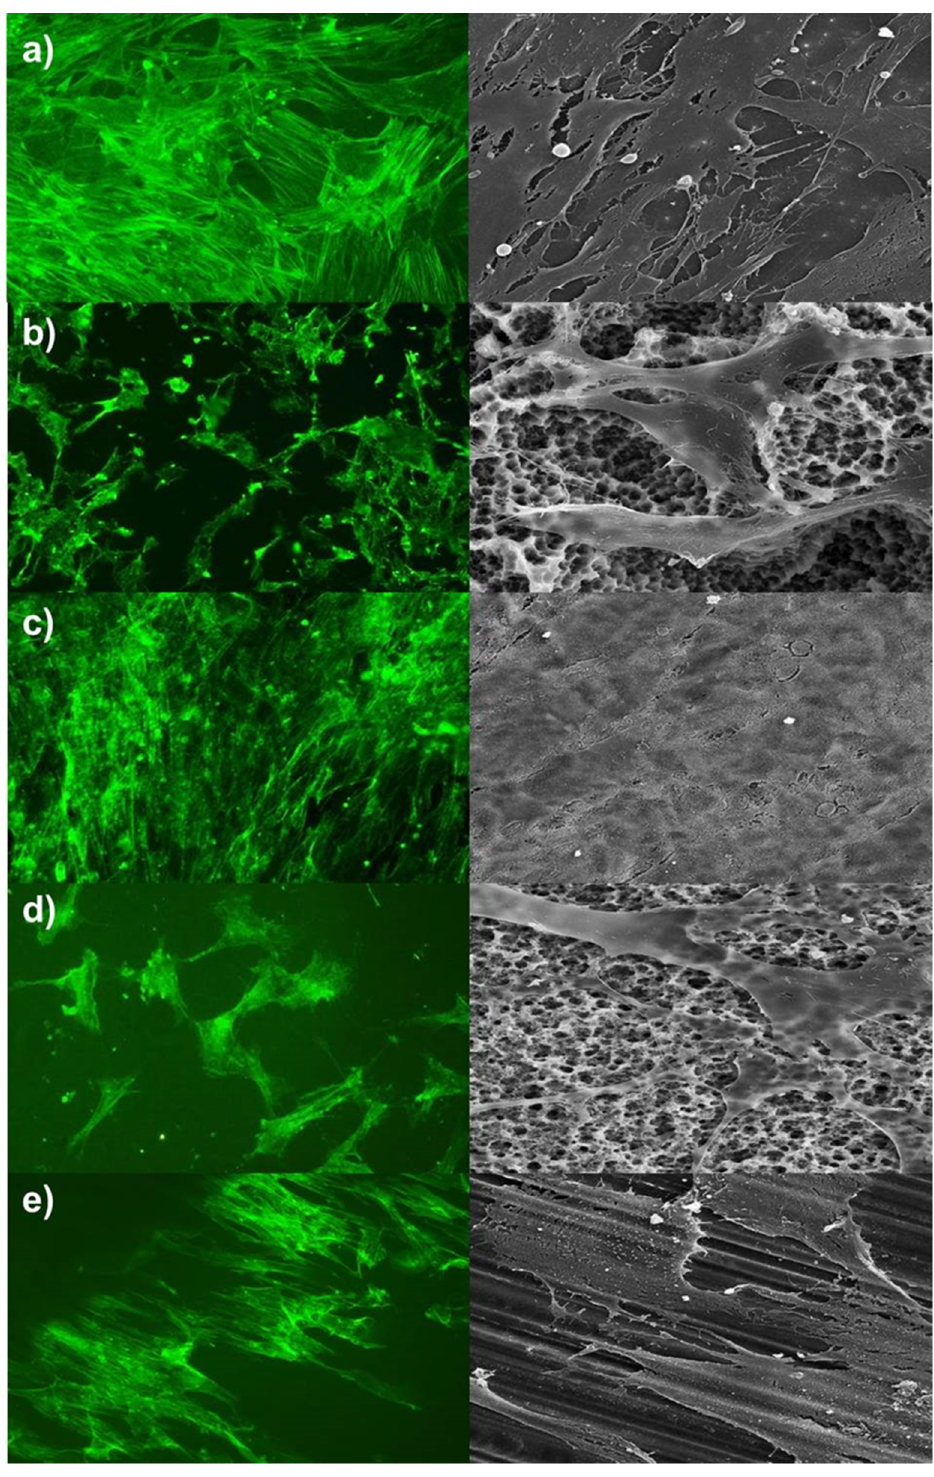
Figure 2. Alterations in the cell morphology of human osteoblasts (hOB). Left site = f-actin staining, magnification factor ×100; right site = SEM, magnification factor ×1200. ( a ) Control, ( b ) Titan-SLA, ( c ) Titan-PT, ( d ) ZrO 2 -ZLA, and ( e ) ZrO 2 -M.